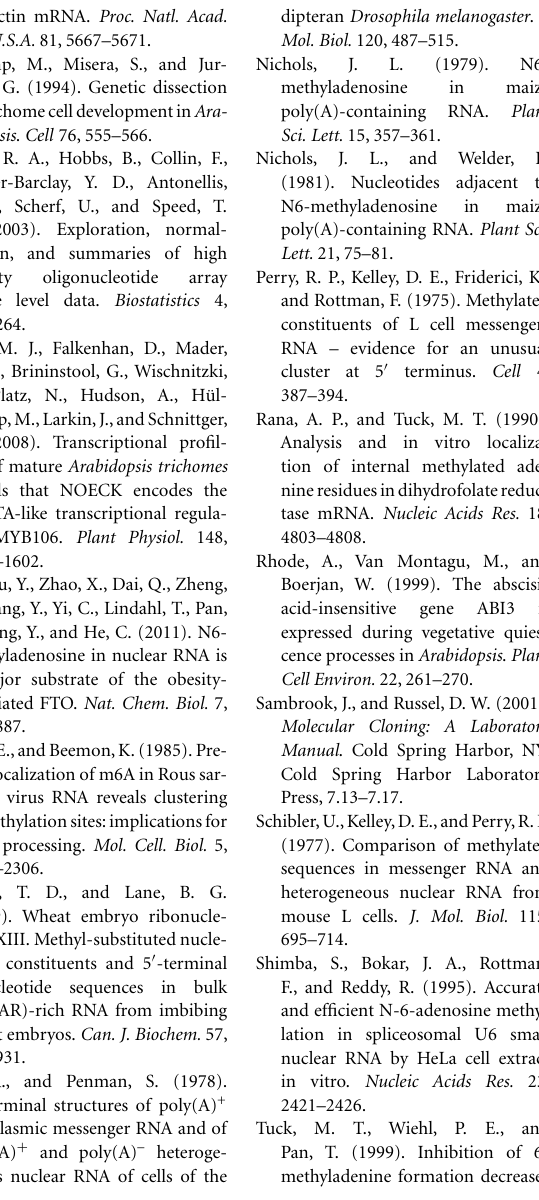
Table S2 | GO enrichment in upregulated gene set. Table S3 | GO enrichment in down regulated gene set. Table S4 | Differentially expressed genes in GO:0008173 RNA methyltransferase activity. Differentially expressed genes in GO:0016070